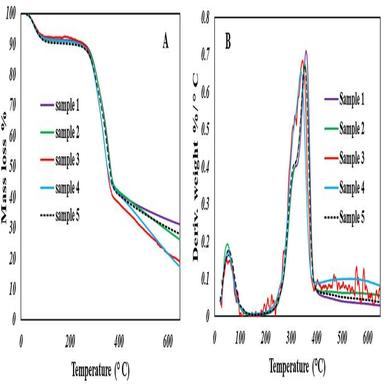
Thermogravimetric analysis of individual RH biomasses (A. Mass loss curves that show the decomposition profiles of the rice husk samples with respect to temperatures; B. Derivative (DTG) of mass loss curves that indicate the rate of decomposition of the rice husk samples). (For interpretation of the references to colour in this figure legend, the reader is referred to the web version of this article.)